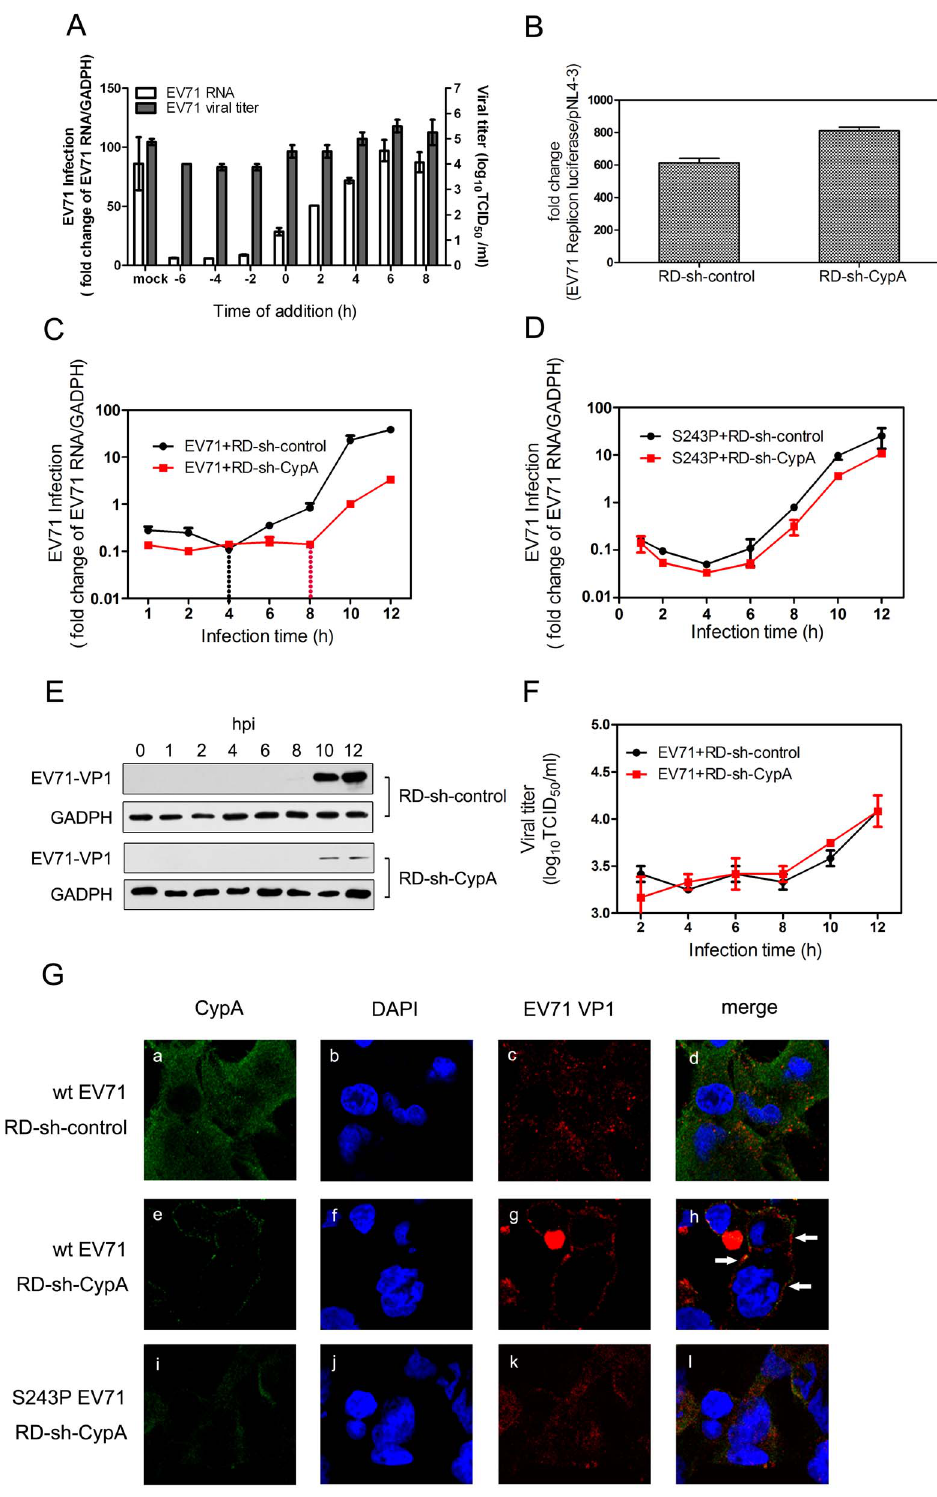
Figure 4. CypA functions in the entry step of EV71 infection. (A) The effect of adding compound HL051001P2 (5 m M) at various times during the replicative cycle of EV71. RD cells were infected by wt-EV71 virus at an MOI of 50 and the inhibitor was added at 2 6, 2 4, 2 2, 0, 2, 4, 6 and 8 hpi. The data for the EV71 genome were expressed as the percentage of EV71 RNA from the untreated control cells; the mRNA level of GAPDH was used as an internal control. The data for EV71 viral titers in the supernatant were measured as previously described. (B) The EV71 subgenomic replicon RNA was transfected into RD-sh-control and RD-sh-CypA cells, and the luciferase levels were quantified by measuring the firefly luciferase activity in relative luminescence units at 24 hpi; the firefly luciferase activity of pNL4-3 was used as an internal control. The growth curves of wt-EV71 (C) and S243P-EV71 (D) in RD-sh-control or RD-sh-CypA cells at an MOI of 50. The EV71 infection was quantified by using qRT-PCR to detect the EV71 RNA in